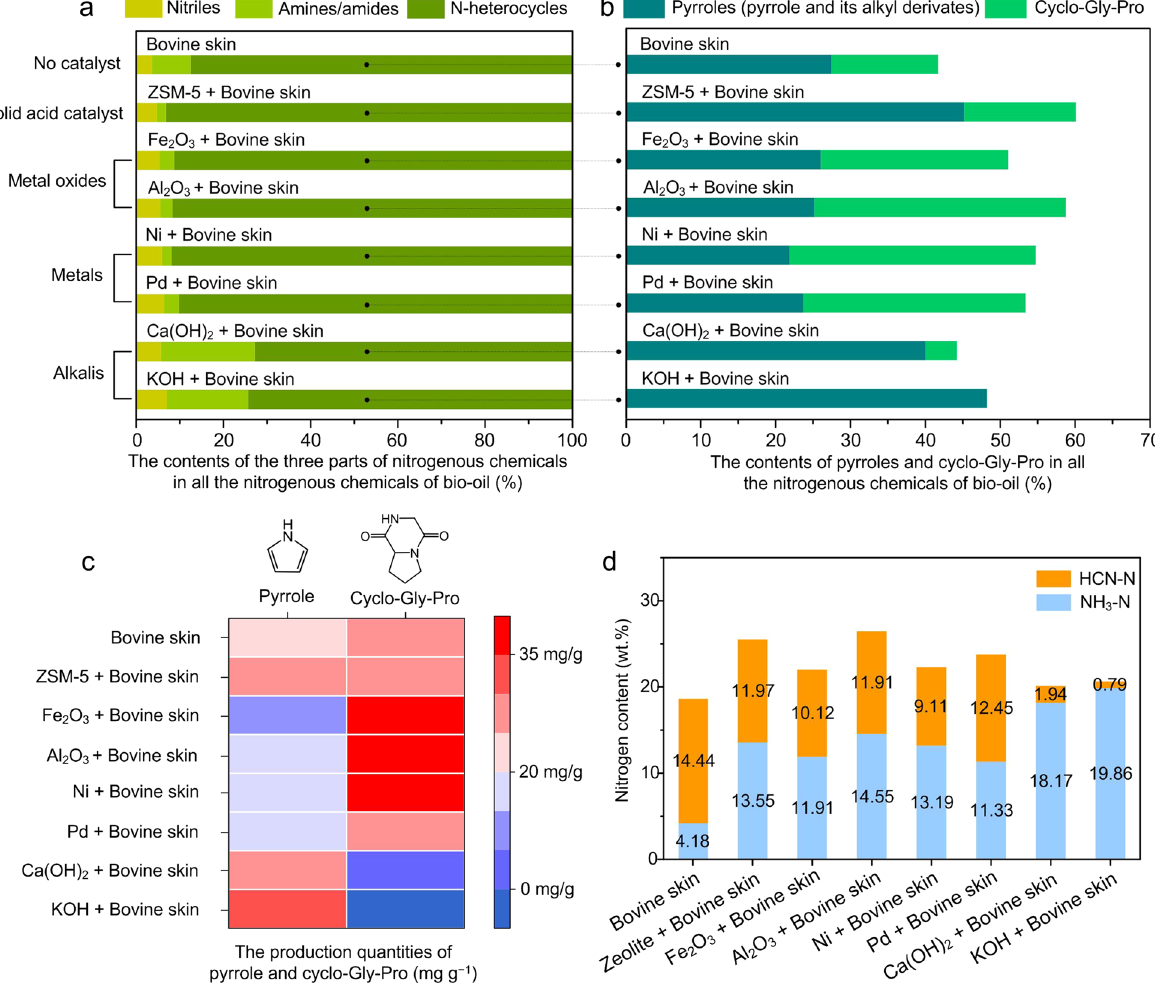
Fig. 5 Nitrogen transformation from bovine skin through TCP at 700 °C with different catalysts. a The contents of the nitrogenous compounds (N-heterocycles, amines/amides, and nitriles) in all the nitrogenous compounds of bio-oil. b The contents of the pyrroles (pyrrole and its alkyl derivates) and cyclo-Gly-Pro in all the nitrogenous compounds of bio-oil. c The actual production quantities of pyrrole and cyclo-Gly–Pro derived from bovine skin (mg g − 1 ). d The nitrogen contents of HCN-N and NH 3 -N in total nitrogen derived from bovine skin after TCP at 700